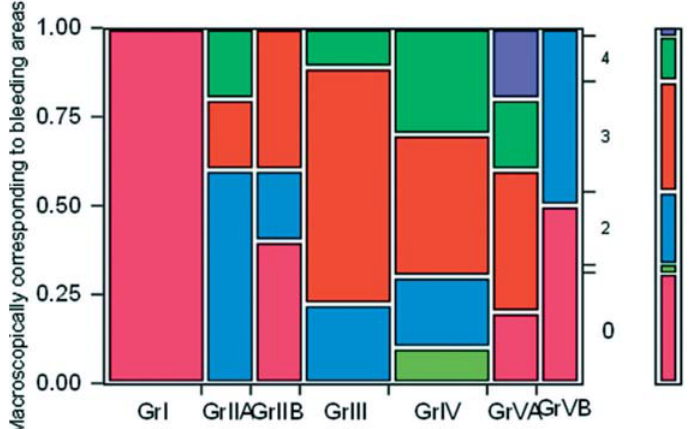
Figure 9- Macroscopic observation of the gastric mucosa in relation to parameter – Macroscopically corresponding to bleeding